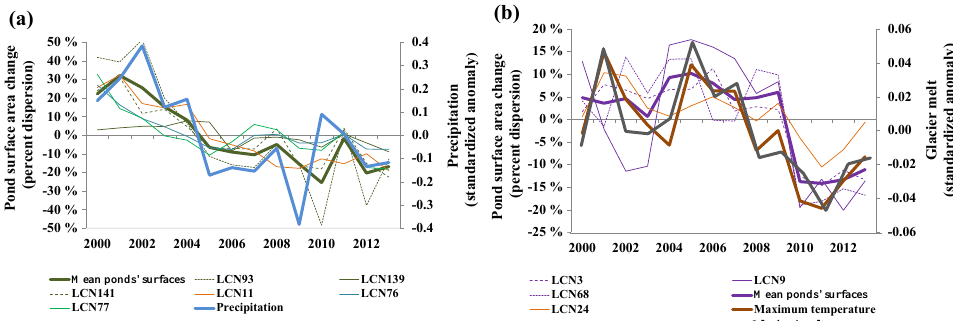
Figure 6. Annual trends from 2000 to 2013 related to pond surface area grouped according to the relevant main drivers of change (monsoon season): (a) precipitation, (b) glacier melt. Coefficients of correlation are reported in Table S5. All trends related to ponds and variables are provided in Figs. S5 and S6. Standardized anomalies (dimensionless) are computed dividing the anomalies by the standard deviation. Percent dispersions are computed dividing the anomalies by the mean.